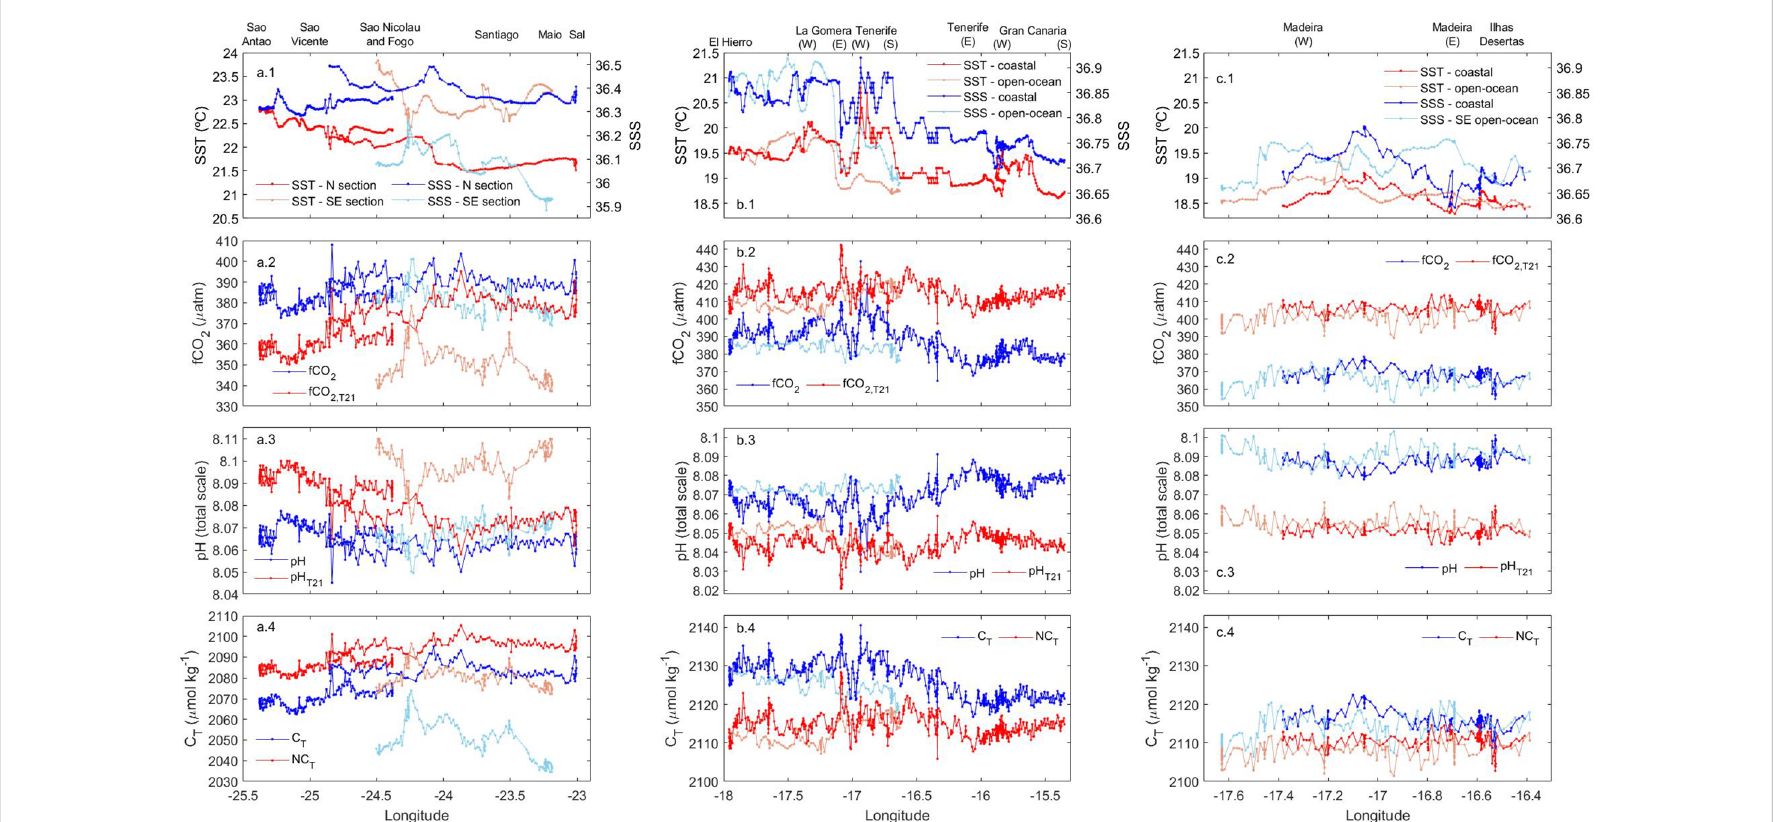
FIGURE 5 Longitudinal distribution of (1) SST (red) and SSS (blue), (2) f CO 2,sw (blue) and f CO 2,T21 (red), (3) pH (blue) and pH T21 (red) and (4) C T (blue) and NC T (red) along the vessel track in (A) the nothern and southeastern sections of Cape Verde (CV-N and CV-SE) and along the coastal and open-ocean sections in the (B) Canary (CA) and (C) Madeira (MA) archipelagos. In CV (A.1-4) , the values for the CV-N section were plotted in dark blue and red, while for CV-SE were plotted in light blue and red. In CA, the open-ocean section goes from stations 18 to 21, while coastal section goes from stations 21 to 43. In MA, the open-ocean section goes from stations 46 to 51 and the coastal section from stations 52 to 62. In the plots for both archipelagos (B.1-4, C.1-4) , the values for the coastal section were represented in dark blue and red while for the open- ocean section were represented in light blue and